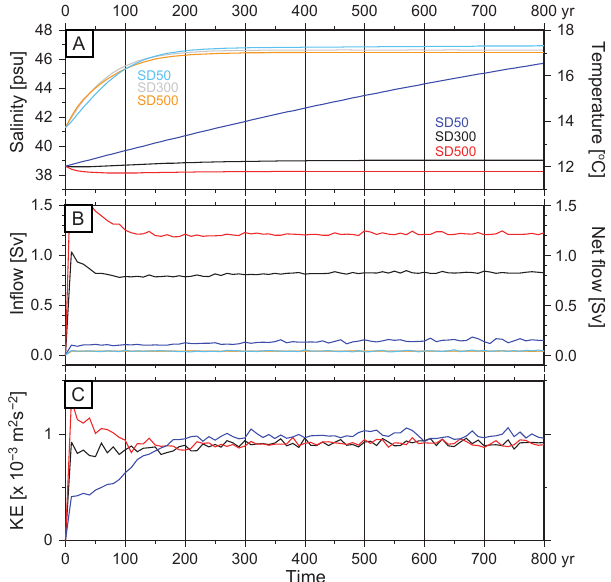
Figure 2. Temporal evolution of diagnostic variables for the ref- erence experiments (SD300, black/grey lines), SD500 (red/orange) and SD50 (blue/light blue). (a) Basin-averaged salinity (dark colours, left vertical axis) and basin-averaged temperature (light colours, right vertical axis). (b) Inflow (dark colours) and net flow (light colours) through the Strait of Gibraltar. (c) Kinetic energy